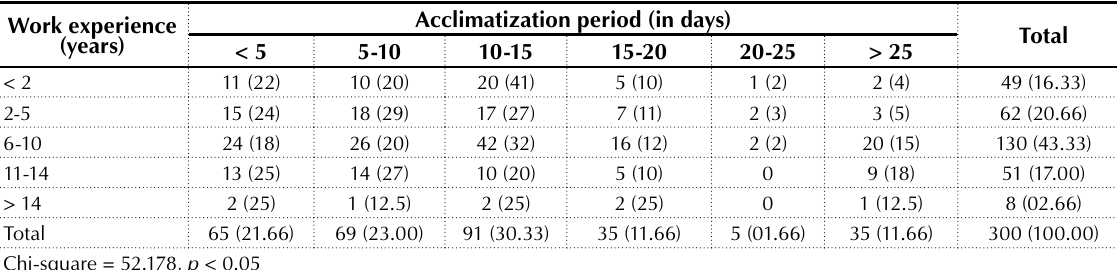
Table 3. Cross tabulation between work experience and acclimatization